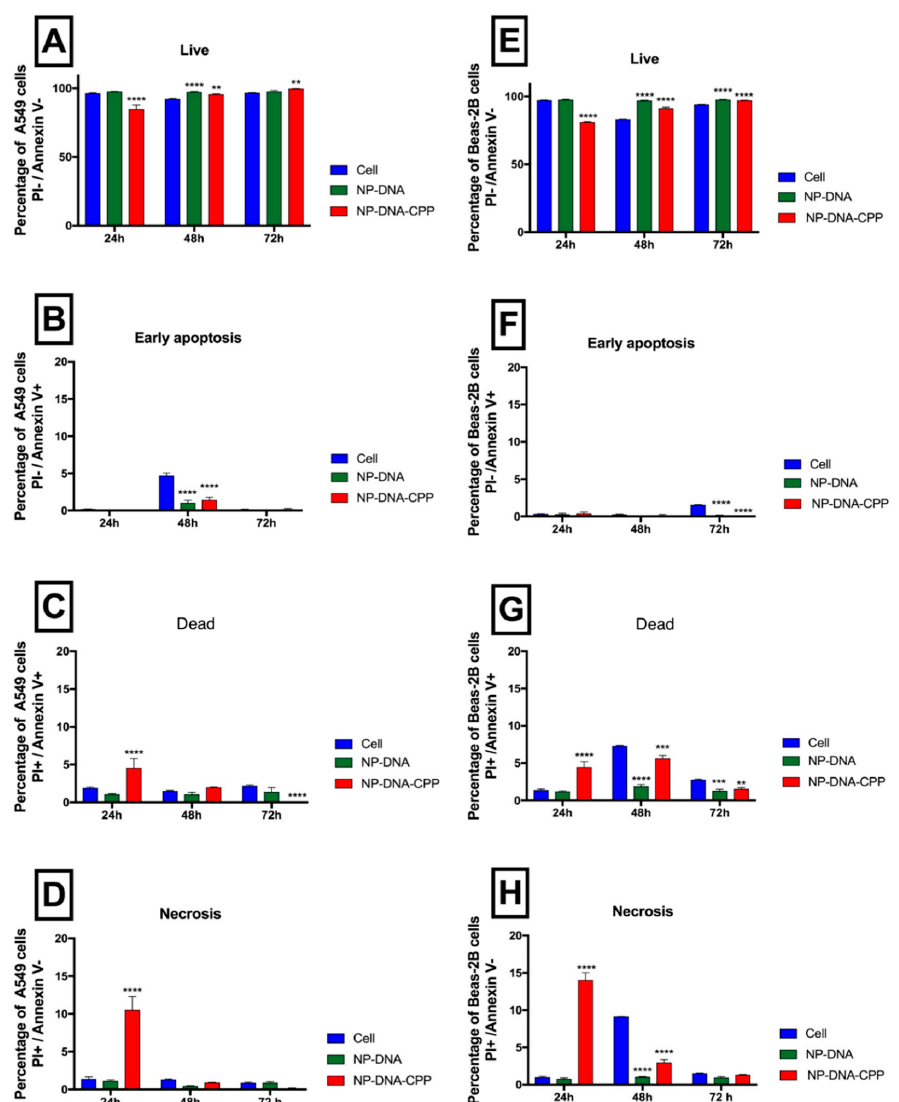
Figure 3. Apoptosis after 24, 48 and 72h of A549 cells (left column) and Beas-2B cells (right